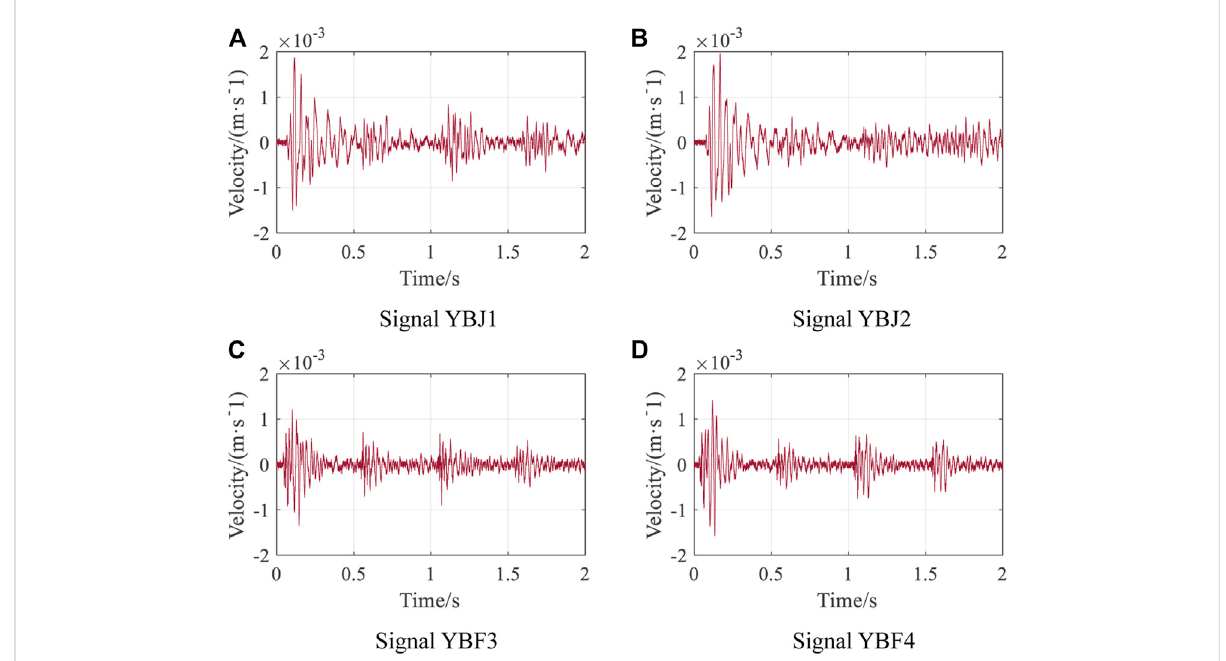
FIGURE 7 Waveforms of original blasting vibration signals generated by different excavation positions of the